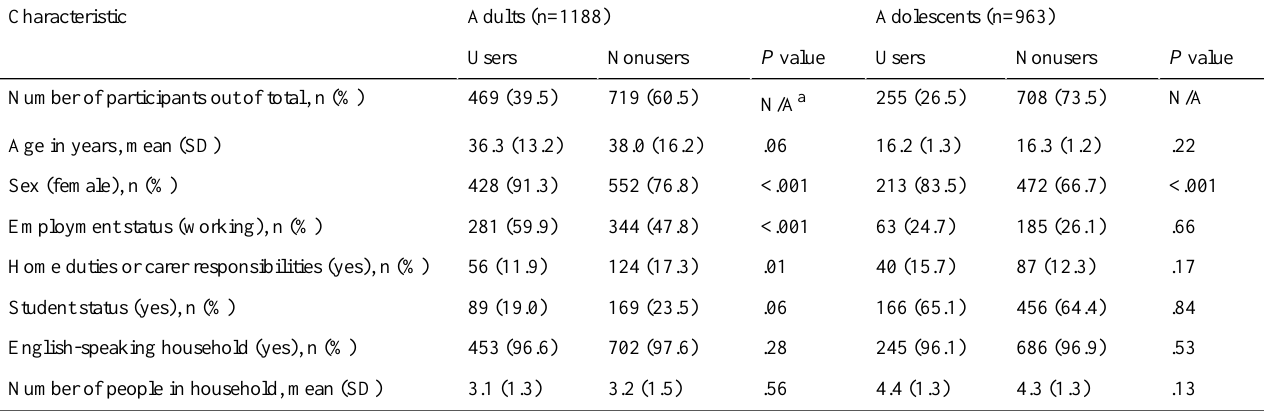
Table 2. Demographic characteristics of users and nonusers of digital platforms for physical activity.